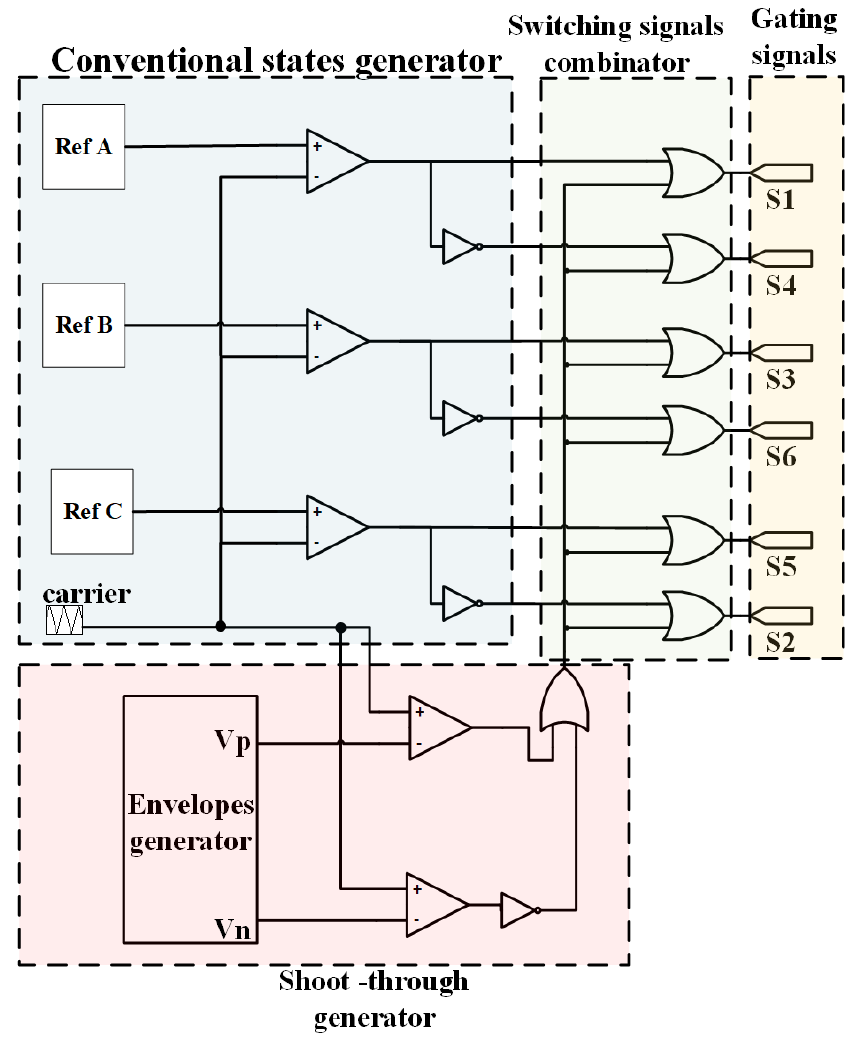
Figure 2. General signal generator block diagram for three-phase ZSI carrier-based PWM techniques.